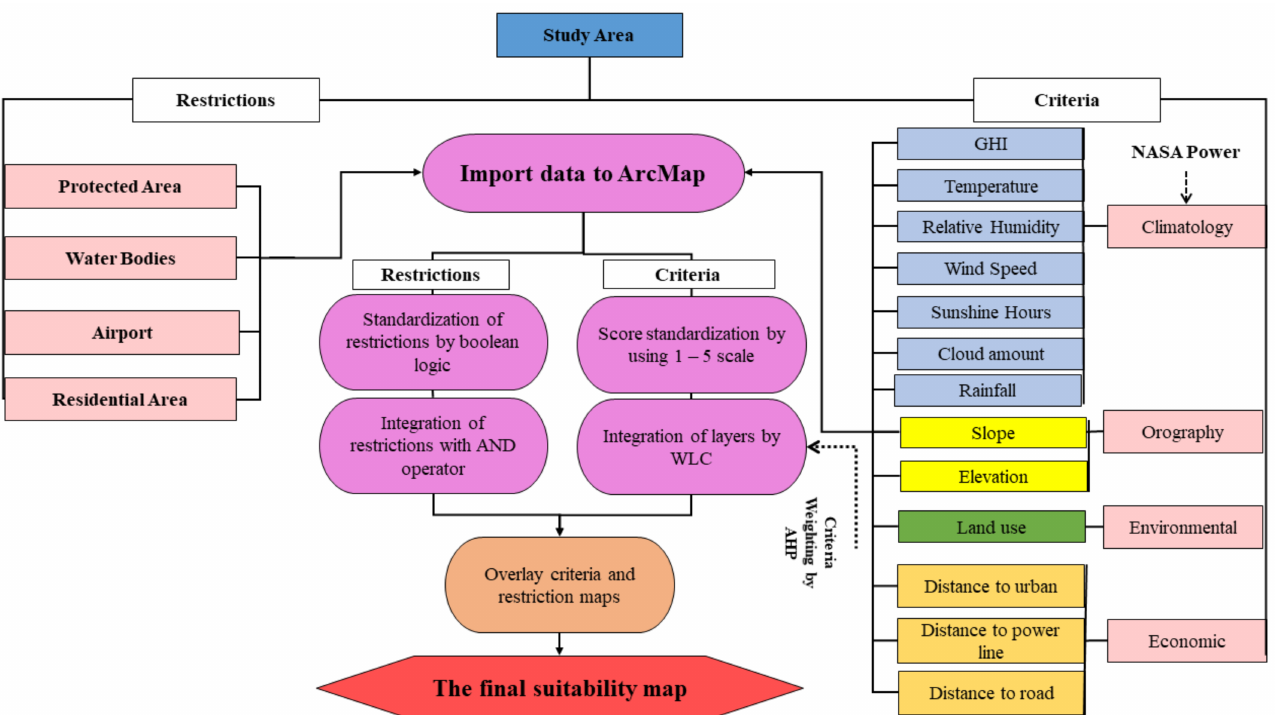
Figure 1. Methodological framework used in the identification of the suitable locations for solar